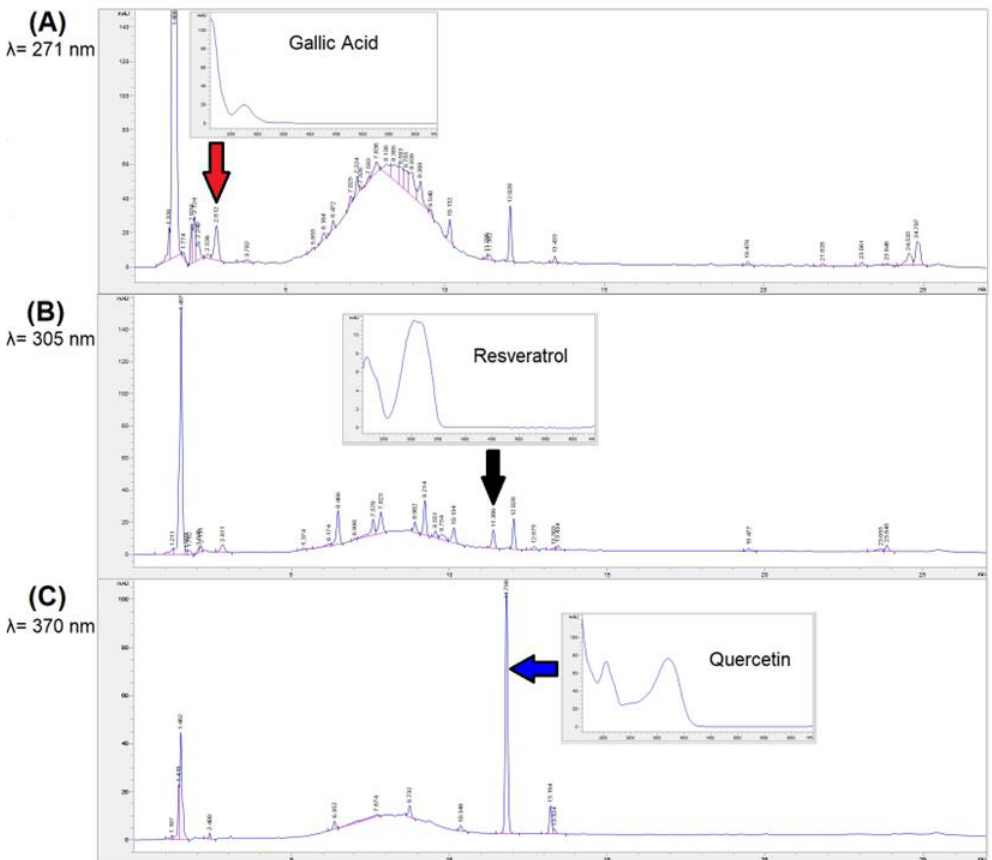
Figure 3. Chromatograms at ( A ) 271 nm; ( B ) 305 nm and ( C ) 370 nm of the PW extract (as a representative sample) employed to evaluate the amount of gallic acid, resveratrol and quercetin respectively. The recorded UV-Vis spectra of the quantified polyphenols are also reported.